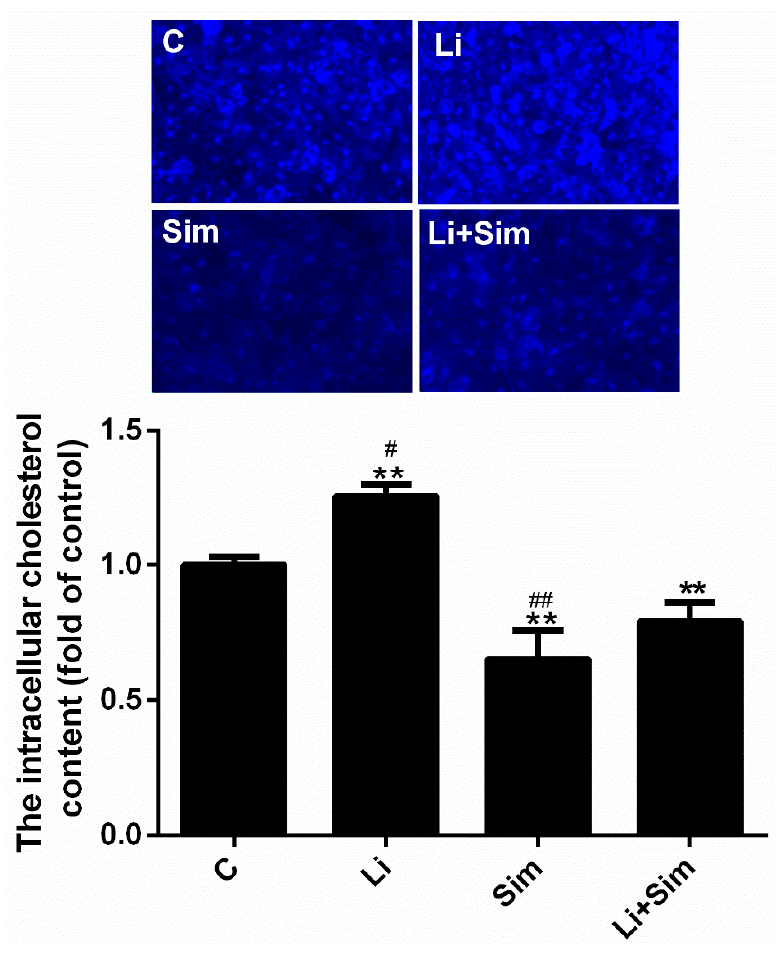
Figure 6. Simvastatin reduces the deposition of cholesterol in the cytoplasm. The intracellular cholesterol was measured by Filipin staining. ** p < 0.001 versus C group; # p < 0.05 or ## p < 0.001 versus Li + Sim group, n = 3. C, HUVECs treated with H 2 O 2 ; Li, C group treated with LiCl; Sim, C group treated with simvastatin; Li + Sim, C group treated with simvastatin and LiCl.